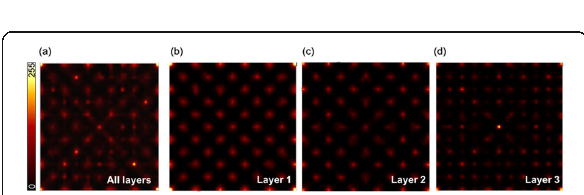
Fig. 3 (abstract A10). (a) Positioning without depth discrimination. In (b) - (d) events are positioned using three depth dependent calibration maps (with N=1k/layer)